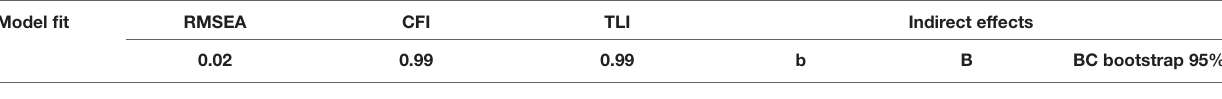
TABLE 1 | PP-LGM mediation model for total students ( n = 15,820).